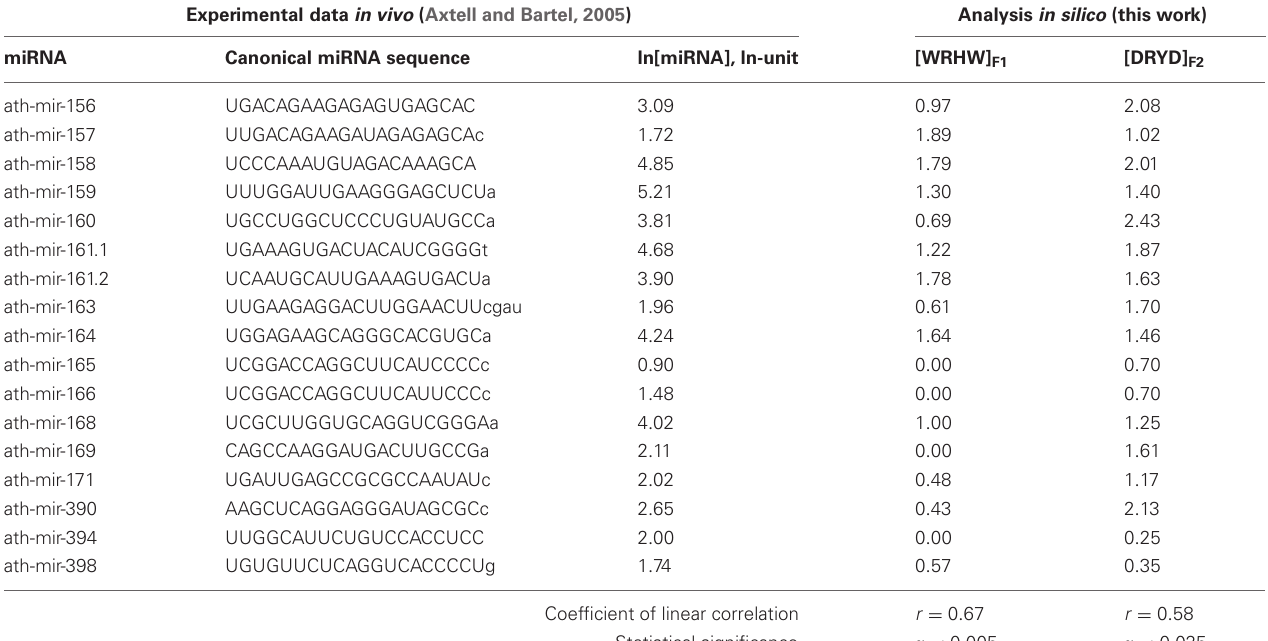
Table 1 | The training dataset (this work) of miRNA abundances in Arabidopsis (Axtell and Bartel, 2005) contains 17 miRNA fragments each 20 nt in length (they are in